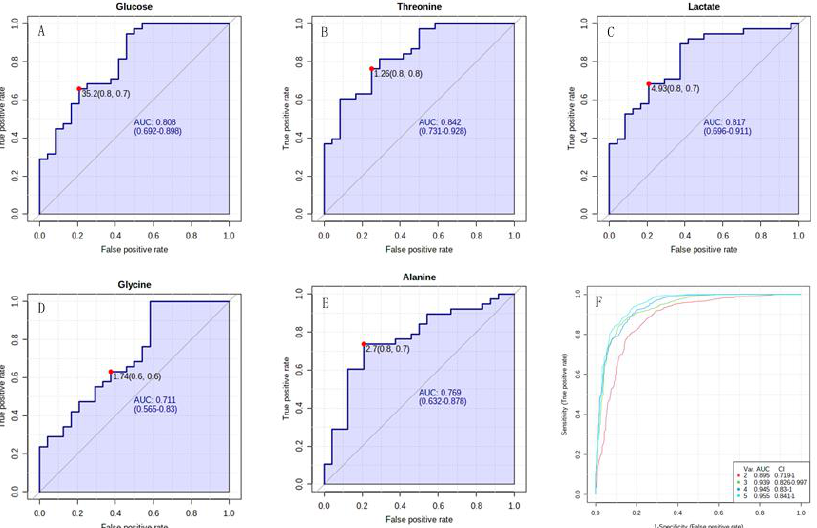
Figure 4. The ROC curve analyses of PAH − CHD vs. CHD. ( A – E ) Univariate ROC curves of five characteristic metabolites for distinguishing PAH − CHD from CHD; ( F ) Multivariate ROC curve of the combination of more than two characteristic metabolites. Each curve corresponded to each combination of different number of characteristic metabolites.